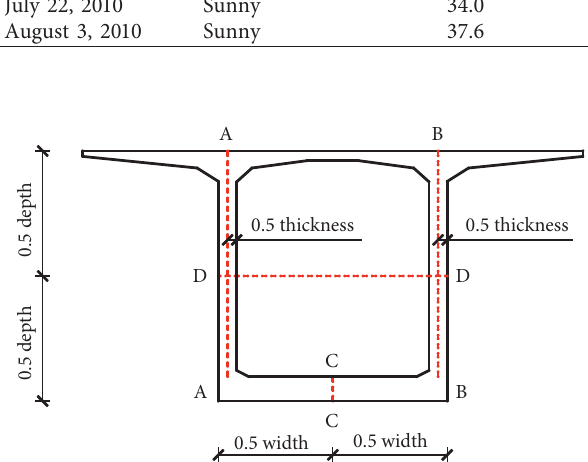
Figure 11: The calculated positions of vertical and transverse temperature